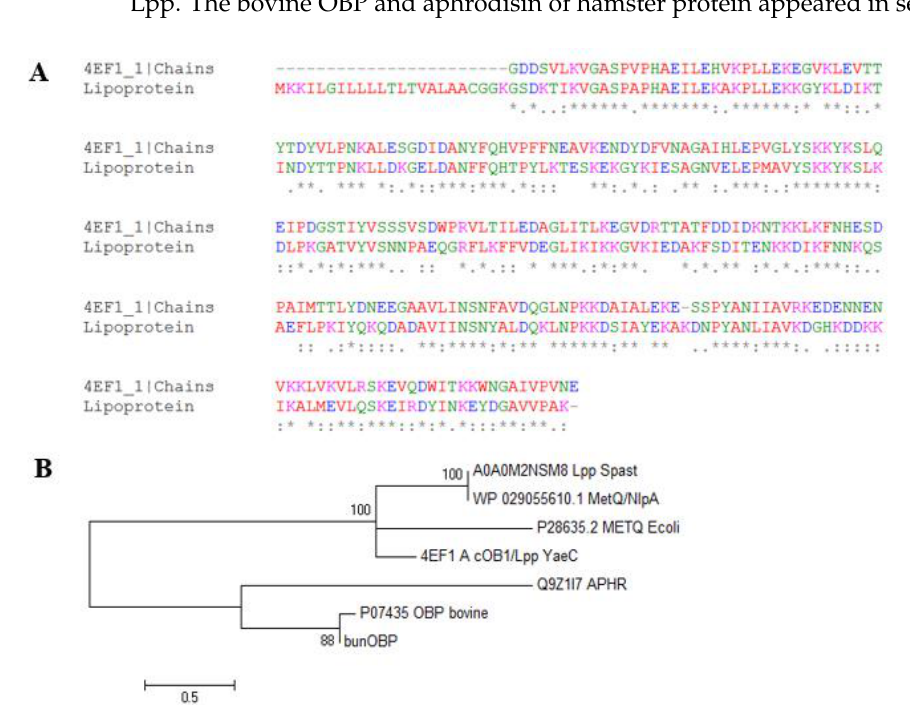
Figure 3. Multiple sequence alignment and phylogenetic tree of Lpp. ( A ). The alignment of Lpp sequence showed several identical residues predicted with the 4EF1. ( B ). The evolutionary tree represents clustering pattern of the selected Lpp, MetQ/NlpA and the OBP proteins.